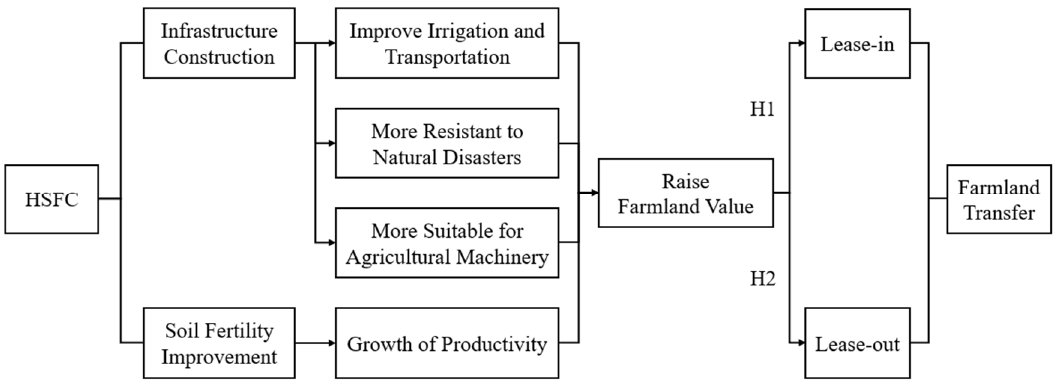
Figure 1. Theoretical Framework of this